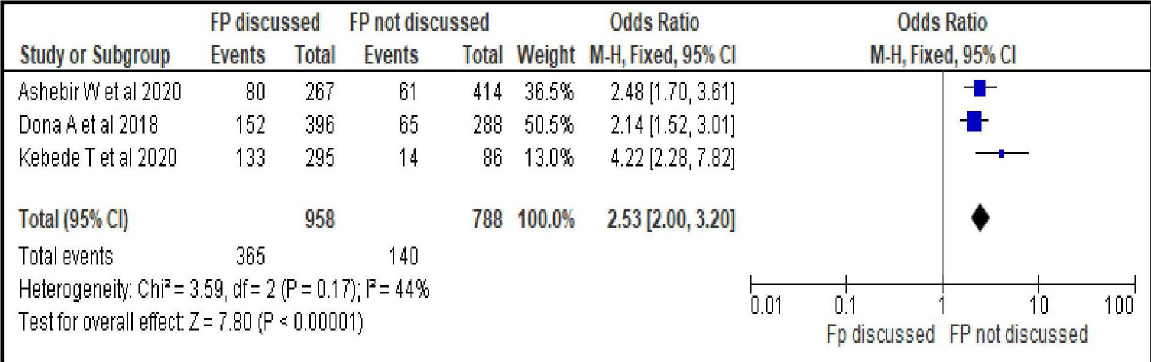
PLOS ONE | https://doi.org/10.1371/journal.pone.0270055 February 7,